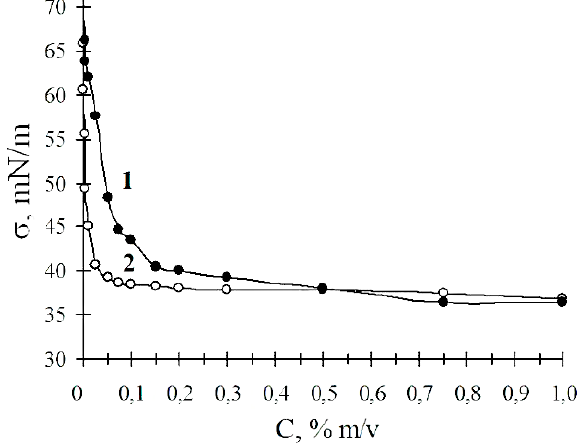
Fig. 1. Surface tension (σ) isotherms for BC aqueous solutions (1) and BC aqueous solutions containing 0.5 %